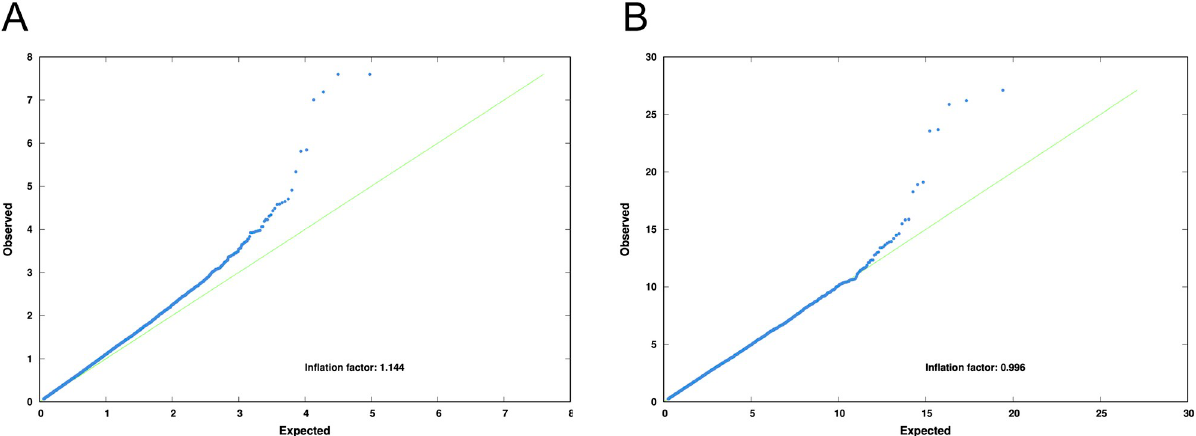
Fig 2. Quantile-quantile plots of Chi-Squared values before (A) and after (B) correction by EMMAX. The blue dots are the SNPs. On the Y axis, the observed Chi-Square value for each SNP, on the X axis is the expected value for each SNP. The green line represents when both expected and observed values coincide (inflation factor = 1).